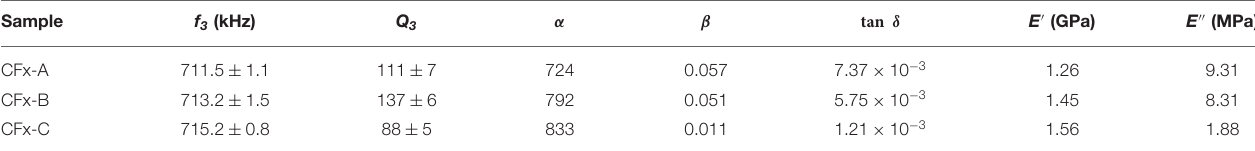
TABLE 2 | Measured values of the contact resonance frequency and quality factor of the third mode of the cantilever ( f 3 and Q 3 , respectively), calculated values of the normalized contact stiffness ( α ) and the normalized damping ( β ) and calculated values of the loss tangent tan δ , storage modulus ( E ′ ) and loss modulus ( E ′′